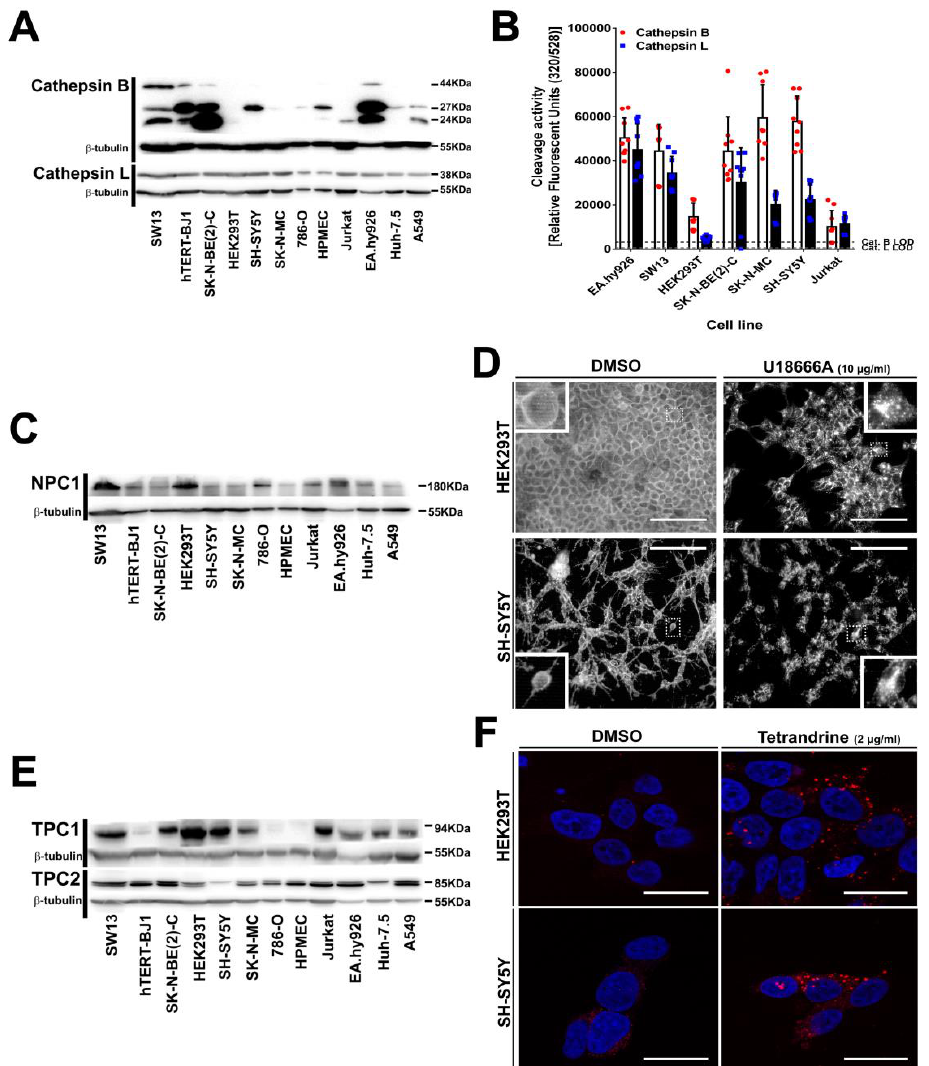
Figure 5. Intracellular entry factors are expressed and functional in SH-SY5Y cells. Endogenous protein expression of ( A ) cathepsin B and L, (C) NPC1, and (E) TPC1 and 2. Cell lysates were analyzed for protein expression by western blotting with protein specific abs. β-tubulin (55 kDa) was used as internal control. ( B ) Cathepsin B and L activity assay. Cathepsins substrate-specific proteolytic cleavage was measured with a commercially available kit as described in methods. Assay limit of detection (LOD) represented as a dotted line. Experiments were conducted thrice with graph bars representing mean experimental value, individual values and SD. ( D ) Intracellular cholesterol accumulation. HEK293T (upper panels) or SH-SY5Y cells (bottom panels) were treated either with vehicle (left) or with 10 µg/mL of the NPC1 inhibitor U18666A (right) for 24 h. Cells were fixed with 0.1% TX100 and stained for unesterified cholesterol using filipin. Images are representative of two independent experiments. Scale bar 200 µm. ( F ) EGF intracellular accumulation. HEK293T (upper panels) or SH-SY5Y cells (bottom panels) were treated either with vehicle alone (left) or with the TPC1/2 inhibitor tetrandrine (2 µg/mL) (right) for 24 h followed by incubation with EGF-Alexa Fluor 555 (red) for 30 min. Cells were fixed with 3% PFA, permeabilized with 0.1% TX100, stained with DAPI (blue) and analyzed by confocal microscopy. Scale bar 20 µm.